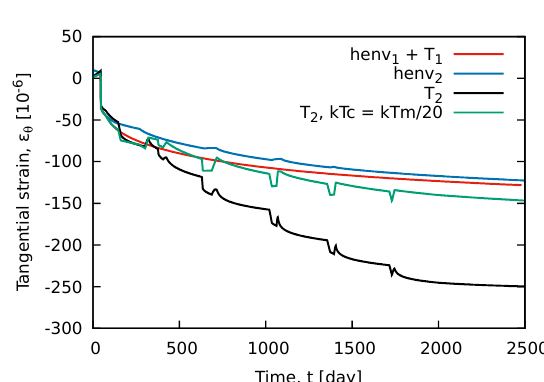
Figure 6. Calibration of material parameter k responsible for the cyclic transient thermal